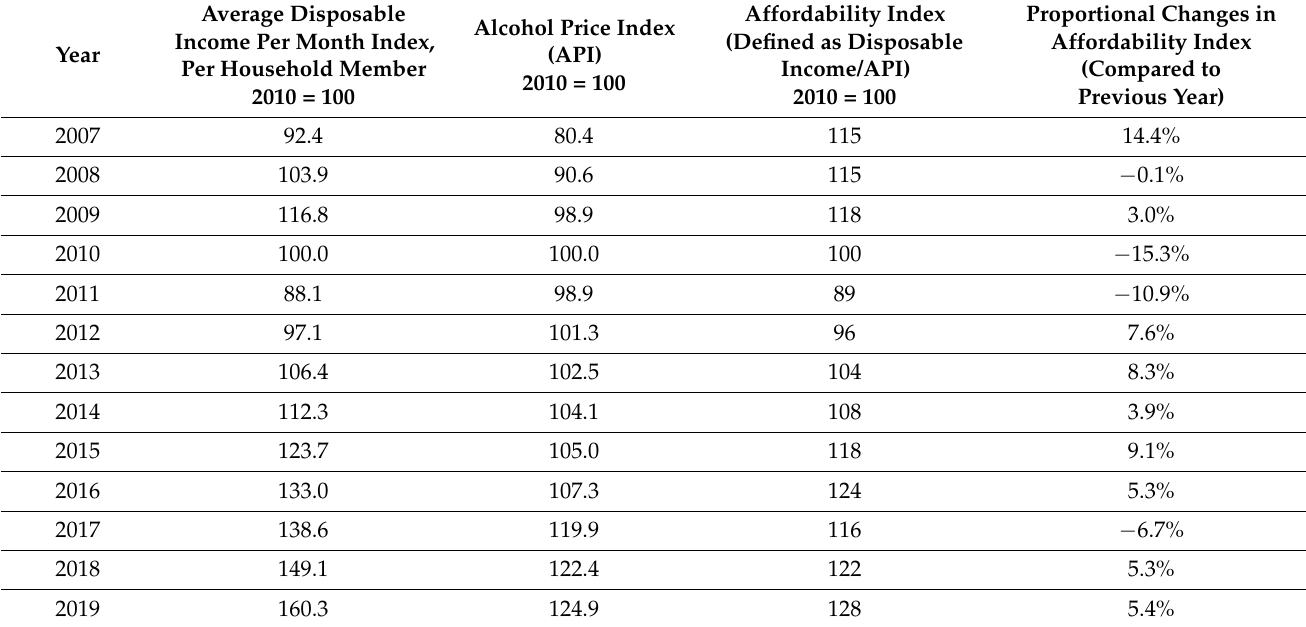
Table 1. Income, alcohol prices, and changes in the affordability index over the period of alcohol policy interventions in